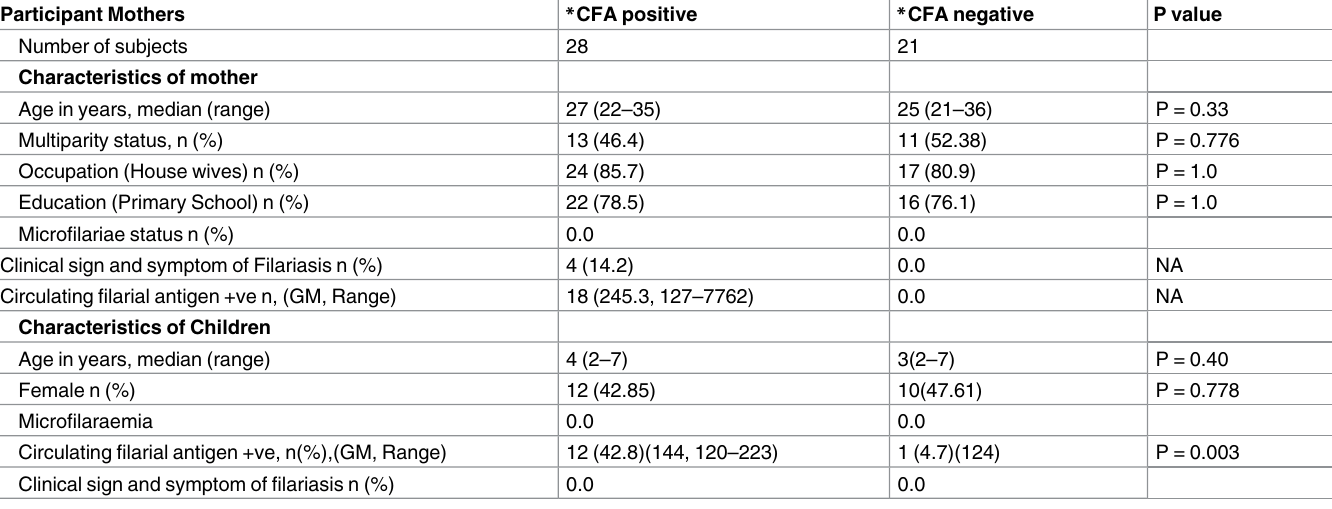
Table 1. Characteristic of CFA positive and CFA negative mothers and their children in the study during follow-up Participant